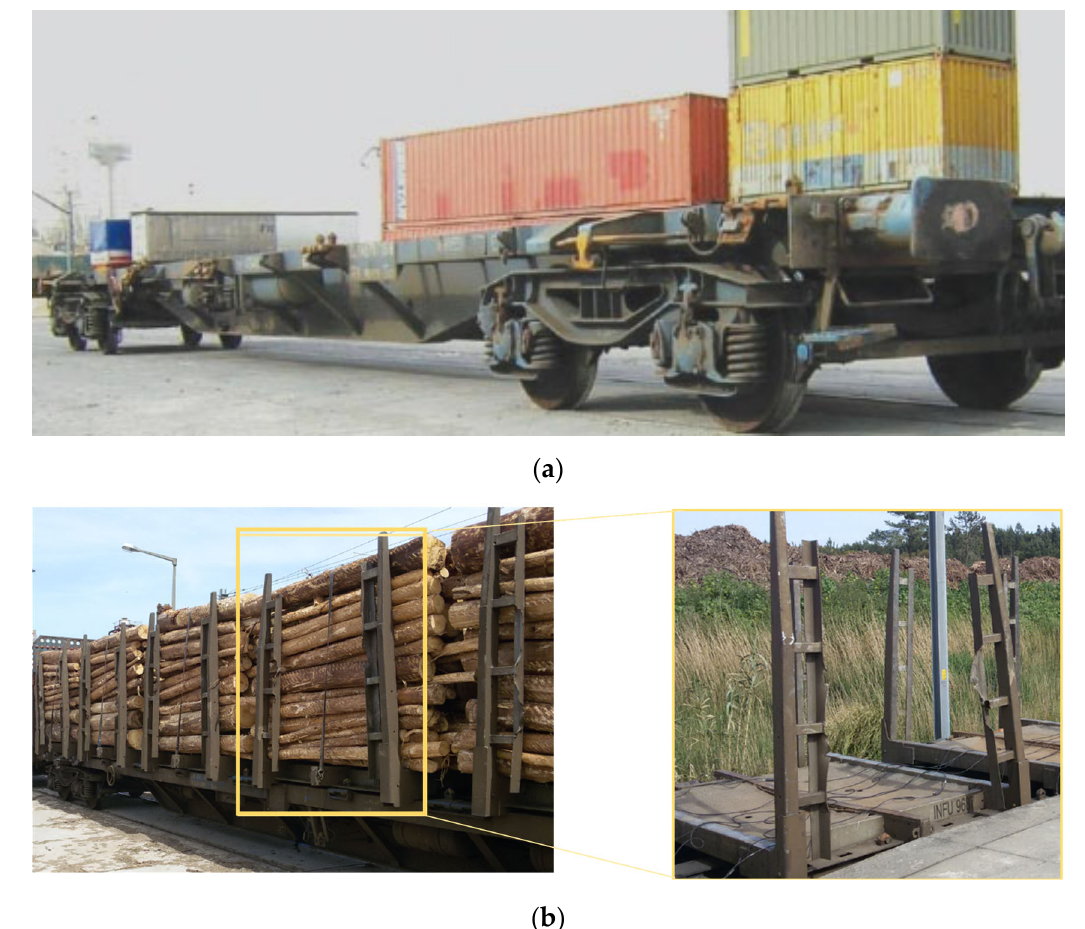
Figure 2. Sgnss wagon: ( a ) layout for containers, ( b ) layout for timber transportation. The vehicle platform is mainly composed by a grid of metallic girders, particularly: two central longitudinal main girders with I ‐ section and variable web height; two longi ‐ tudinal side beams, one on each side; and transversal girders embracing all the longitudi ‐ nal girders, as presented in Figure 3. The vehicle platform only exists at both extremities of the wagon and is formed by a 2.0 ‐ millimetre ‐ thick steel plate.